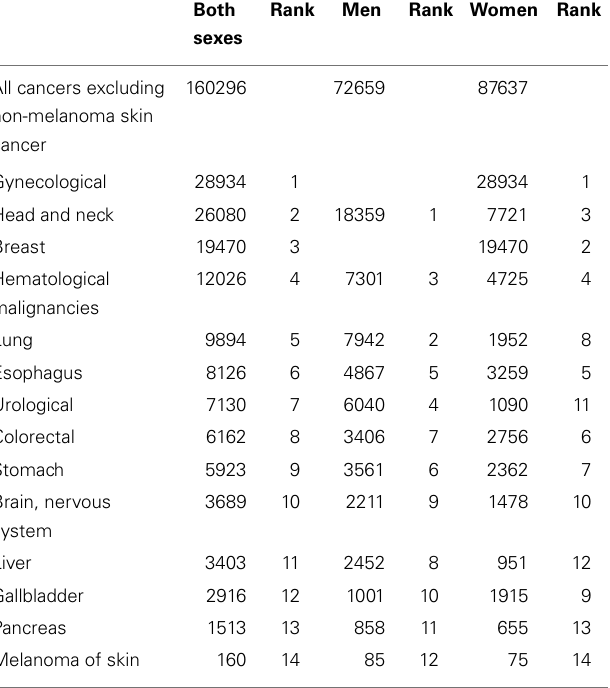
Table 1 |The most common cancers in Uttar Pradesh for men and women based upon GLOBOCAN 2008 data .